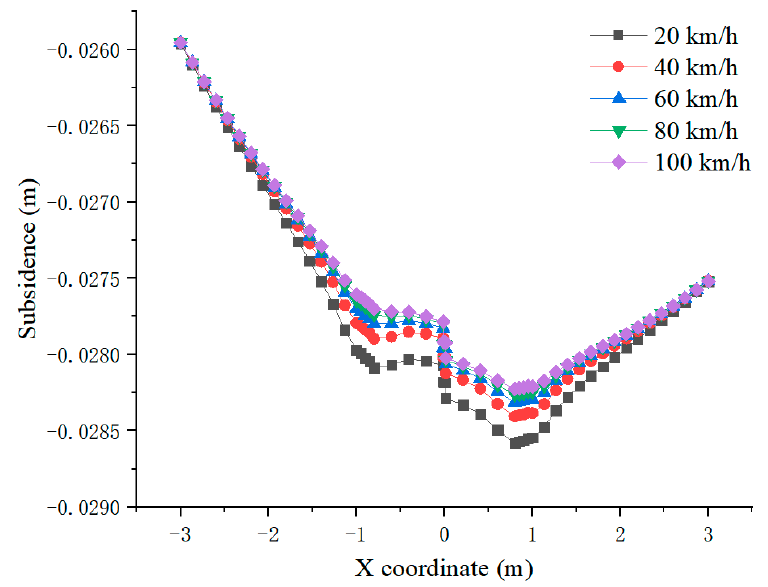
Figure 17. Distribution of dam subsidence at 14.625 m under different vehicle speeds.